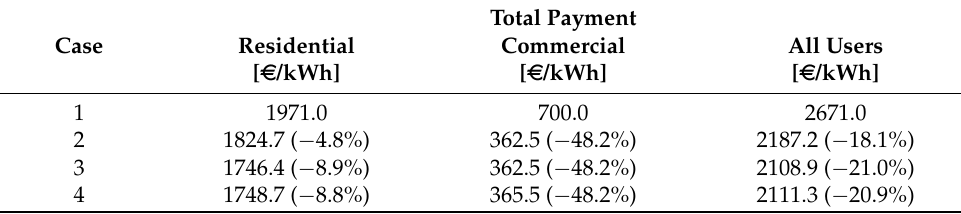
Table 2. Users payments by each case and the reduction percentage with respect to Case 1.